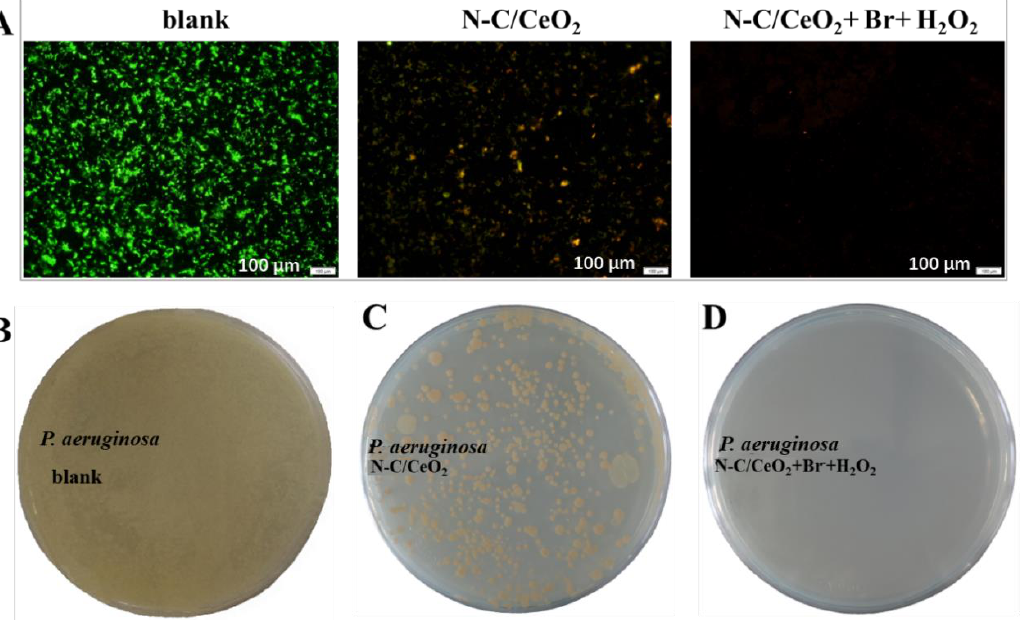
Figure 5. ( A ) Cell staining images of P. aeruginosa treated with titanium plate in different systems: blank, N-C/CeO 2 , and N-C/CeO 2 + Br - + H 2 O 2 , P. aeruginosa agar photo; ( B ) blank; ( C ) after adding N-C/CeO 2 ; and ( D ) after adding N-C/CeO 2 + Br - + H 2 O 2 . Note: the concentration of P. aeruginosa is 10 7 cfu·mL − 1 .